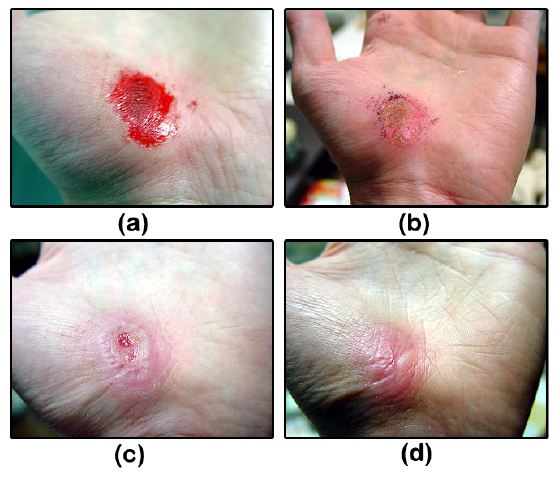
Figure 5. Skin wound healing. Hand abrasion ( a ) on the day of injury; ( b ) three days after injury; ( c ) 17 days after injury; and ( d ) 30 days after